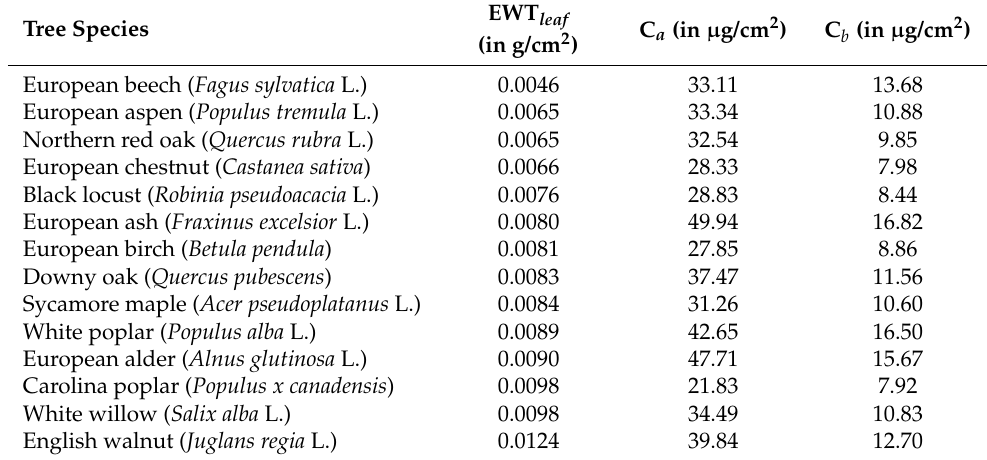
Table 5. Equivalent water thickness (EWT) and chlorophyll a (C a ) and b (C b ) concentrations at leaf level for different tree species derived from the LOPEX and ANGERS leaf optical properties databases